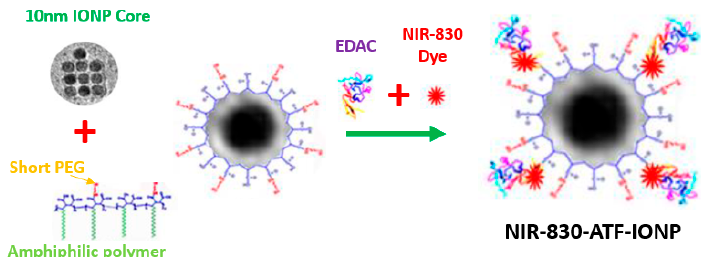
7 of 10 Figure 6. Schematic of the miniaturized FMT endoscopic system. 4.2. Nanoparticle Magnetic iron oxide nanoparticles (IONP) were prepared by Ocean Nanotech LLC using iron oxide powder as the iron precursor, oleic acid as the ligand, and octadecene as the solvent [40]. The IONP particles, with a core size of 10 nm, were coated with amphiphilic polymers using a similar method as reported previously [41]. Amino-terminal fragment (ATF) peptides were conjugated to the surface of IONP mediated by the cross-linking of carboxyl groups on the coated polymer to amino side groups on the ATF peptides, as shown in Figure 7. Briefly, polymer-coated IONPs were activated by ethyl-3-dimethyl amino propyl carbodiimide (EDAC, Pierce, Rockford, IL, USA) and sulfo-NHS for 15 min. After purification using Nanosep 100k OMEGA (Pall Corp, Ann Arbor, MI, USA), NIR